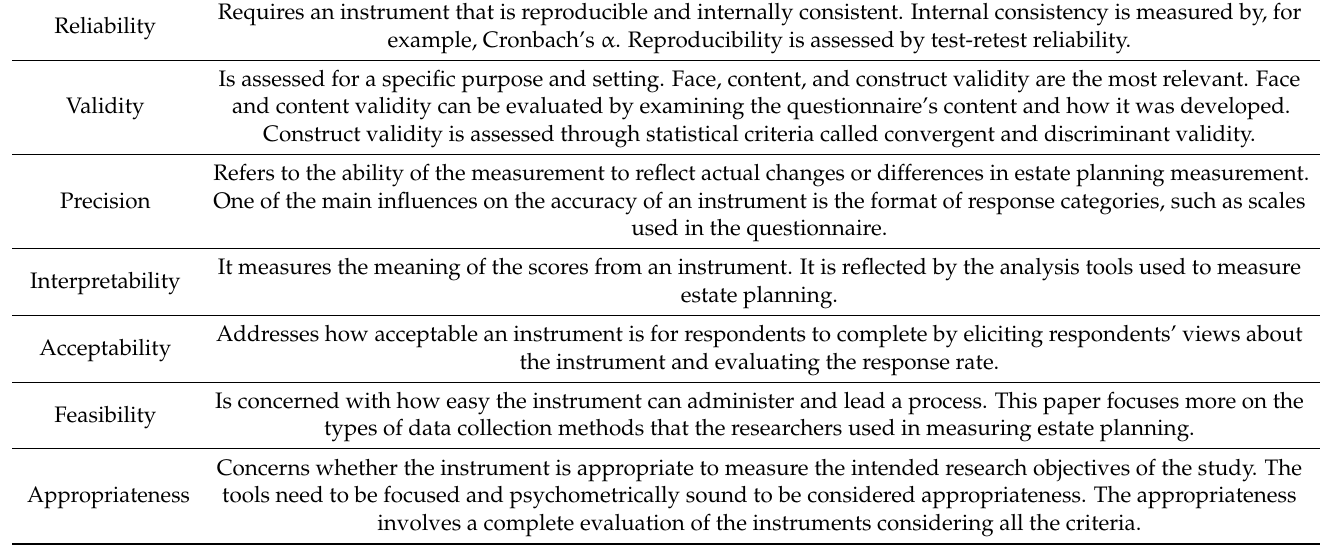
Table 3. Criteria to evaluate estate planning measurement (adapted from Bing-Jonsson et al.